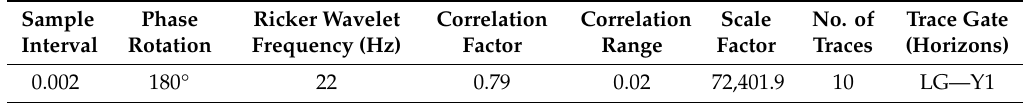
Table 1. Selected parameters for optimum wavelet estimation.